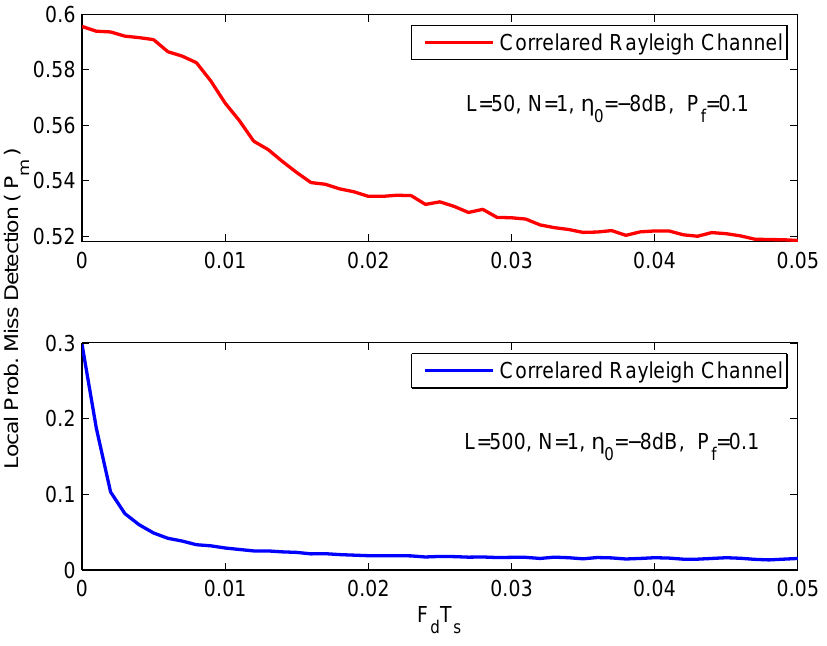
Figure 4. The local probability of misdetection as a function of F d T s